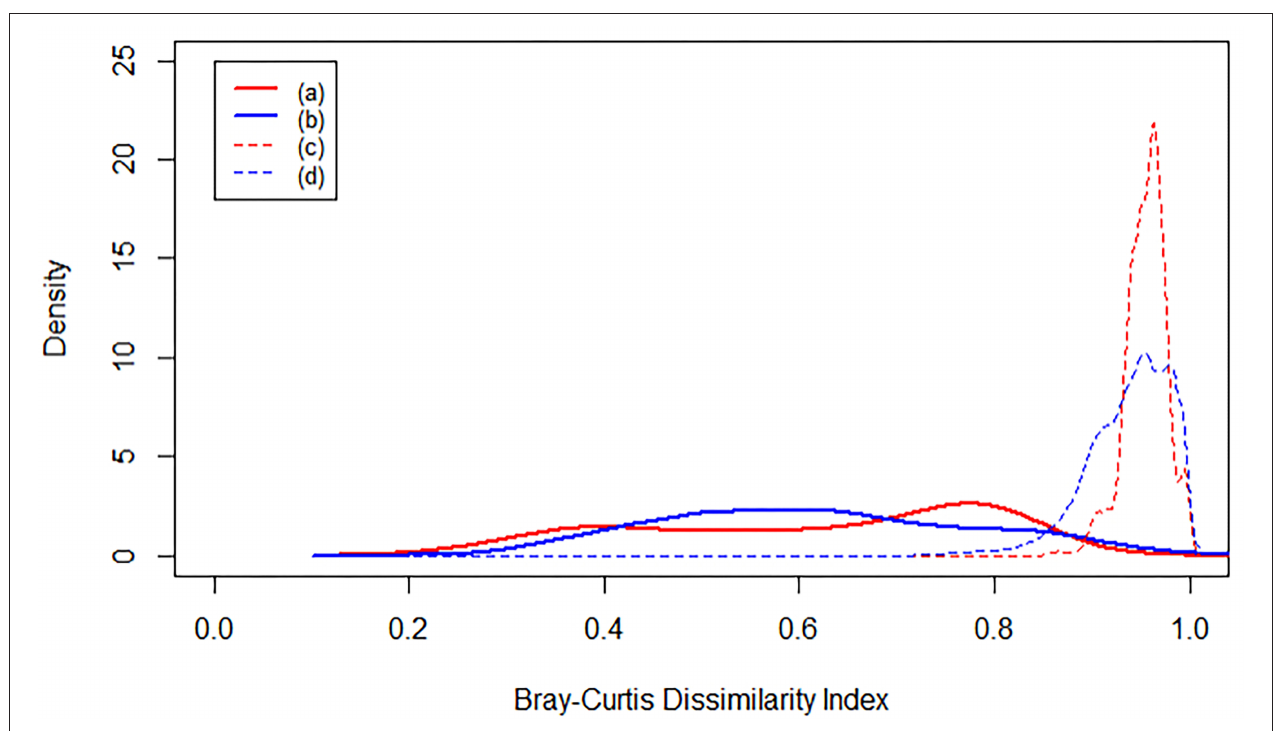
FIGURE 6 | Kernel density plots of Bray-Curtis dissimilarity index. Each line represents an averaged density function. (a) is the dissimilarity between each flume sample and all the other flume samples. (b) is the dissimilarity between each river sediment sample and all the other river sediment samples from the same study. (c) is the dissimilarity between each flume sample and all of the river sediment samples, and (d) is the dissimilarity between each river sediment sample and all the other river sediment samples from all